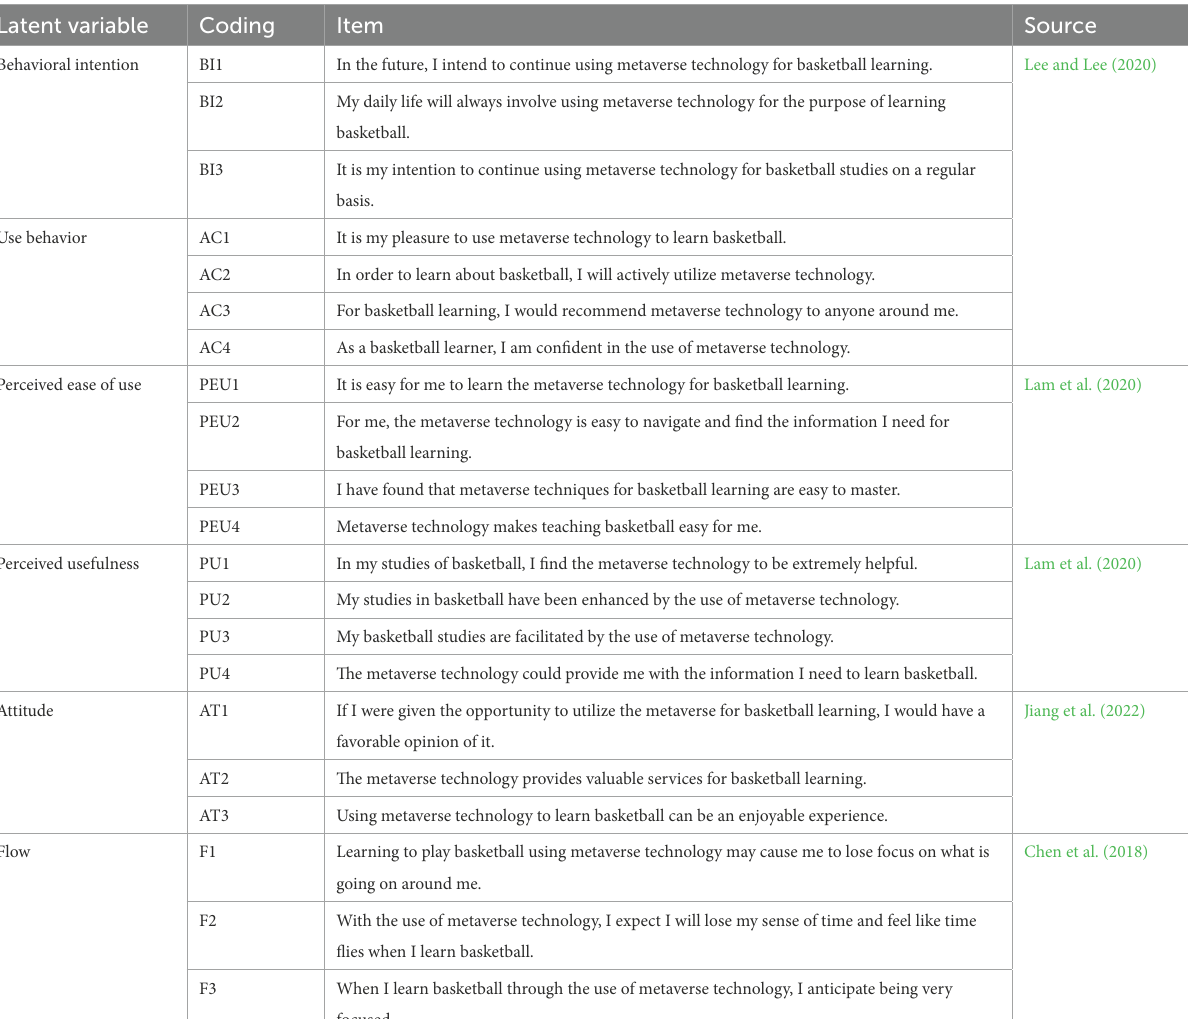
TABLE 1 The scale of